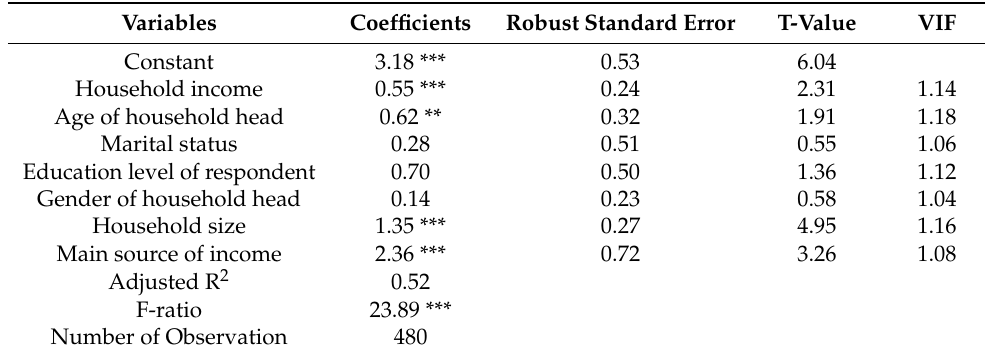
Table 9. Determinants of food expenditure in rural farming